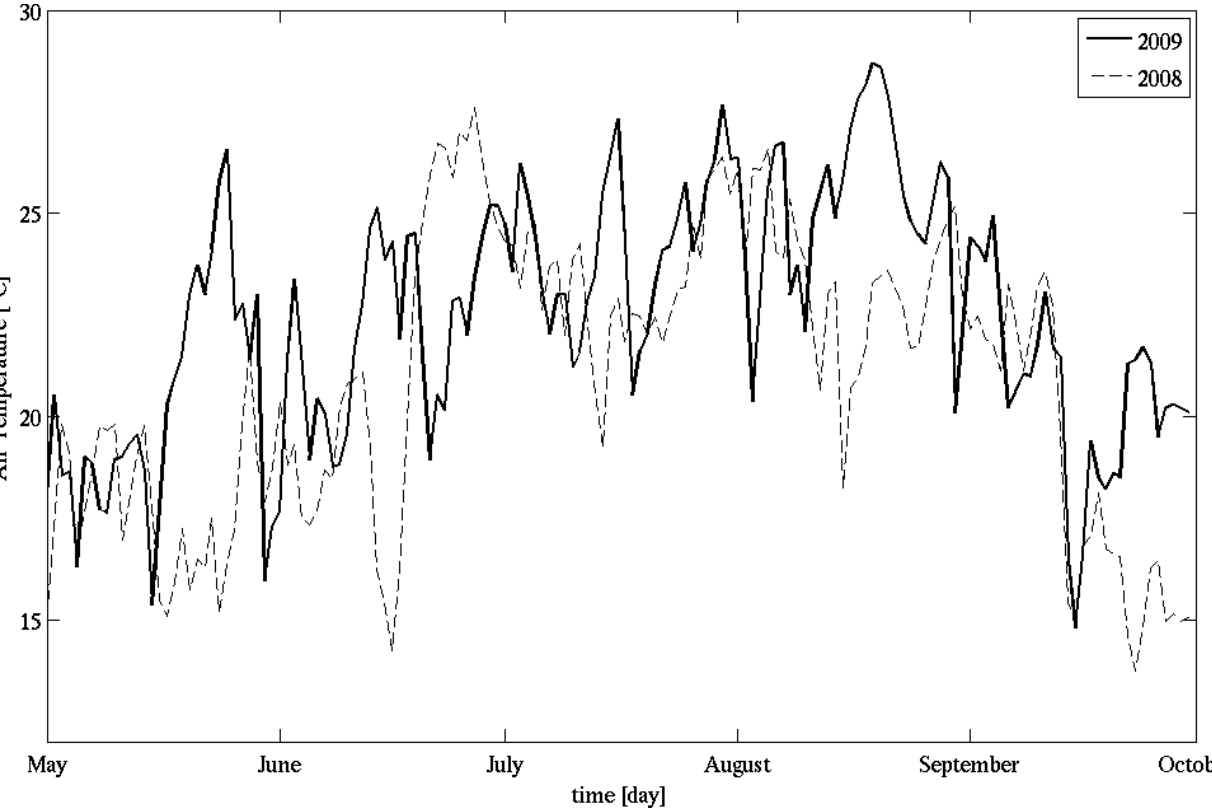
Figure 2. Mean daily air temperature (in ◦ C) measured in the shelter during 2008 and 2009 vegetative seasons above the Barbera vines at Cocconato.